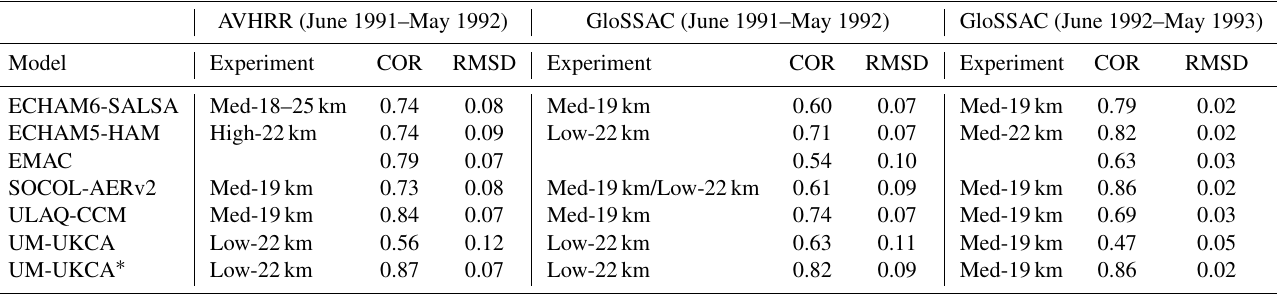
Table 2. Correlation (COR) and root-mean-square difference (RMSD) of the stratospheric AOD calculated between observations and model results for the experiments that best reproduce the observations.